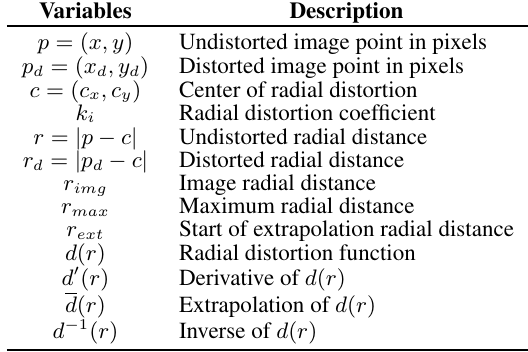
Table 1. List of mathematical